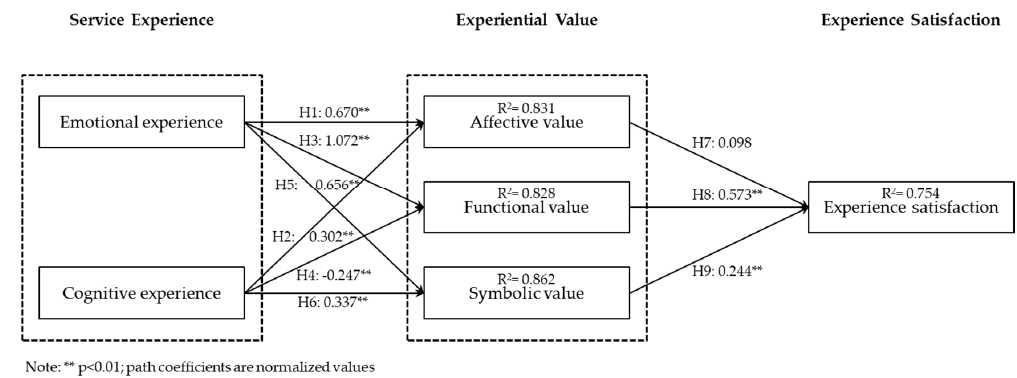
Figure 3. Path analysis of the structural model.